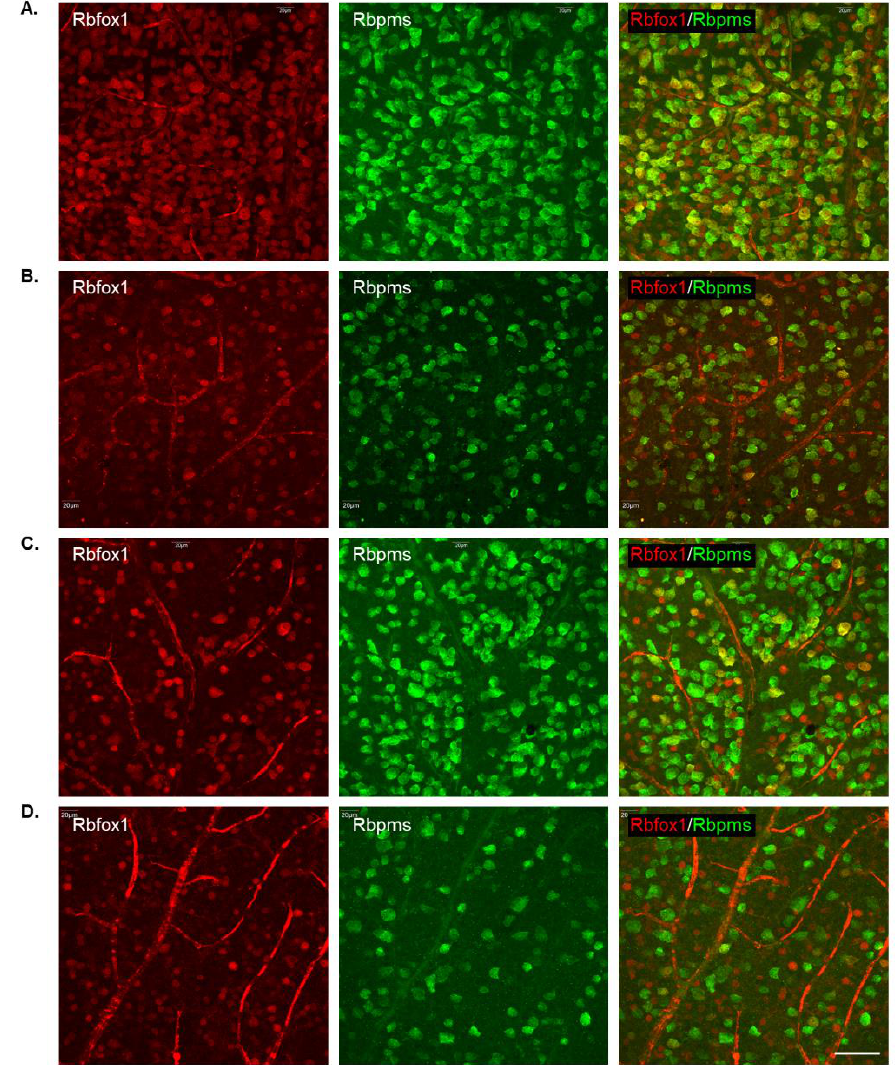
6273 ± 1673 and 6004 ± 1531 Rbpms-positive cells/mm 2 for control and Rbfox1 KO mice, cells in retinas of control and Rbfox1 KO mice were decreased to 2998 ± 858 cells/mm 2 and 3036 ± 857 cells/mm 2 , respectively ( n = 4/group; Figure 5B). These numbers indicate ap- proximately 50% RGC loss caused by ONC compared to uninjured animals (control vs. control + ONC, p = 2.75 × 10 − 27 and Rbfox1 KO vs. Rbfox1 KO + ONC, p = 2.55 × 10 − 26 ).